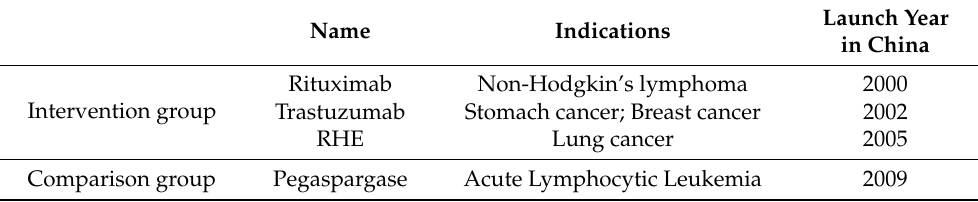
Name Indications